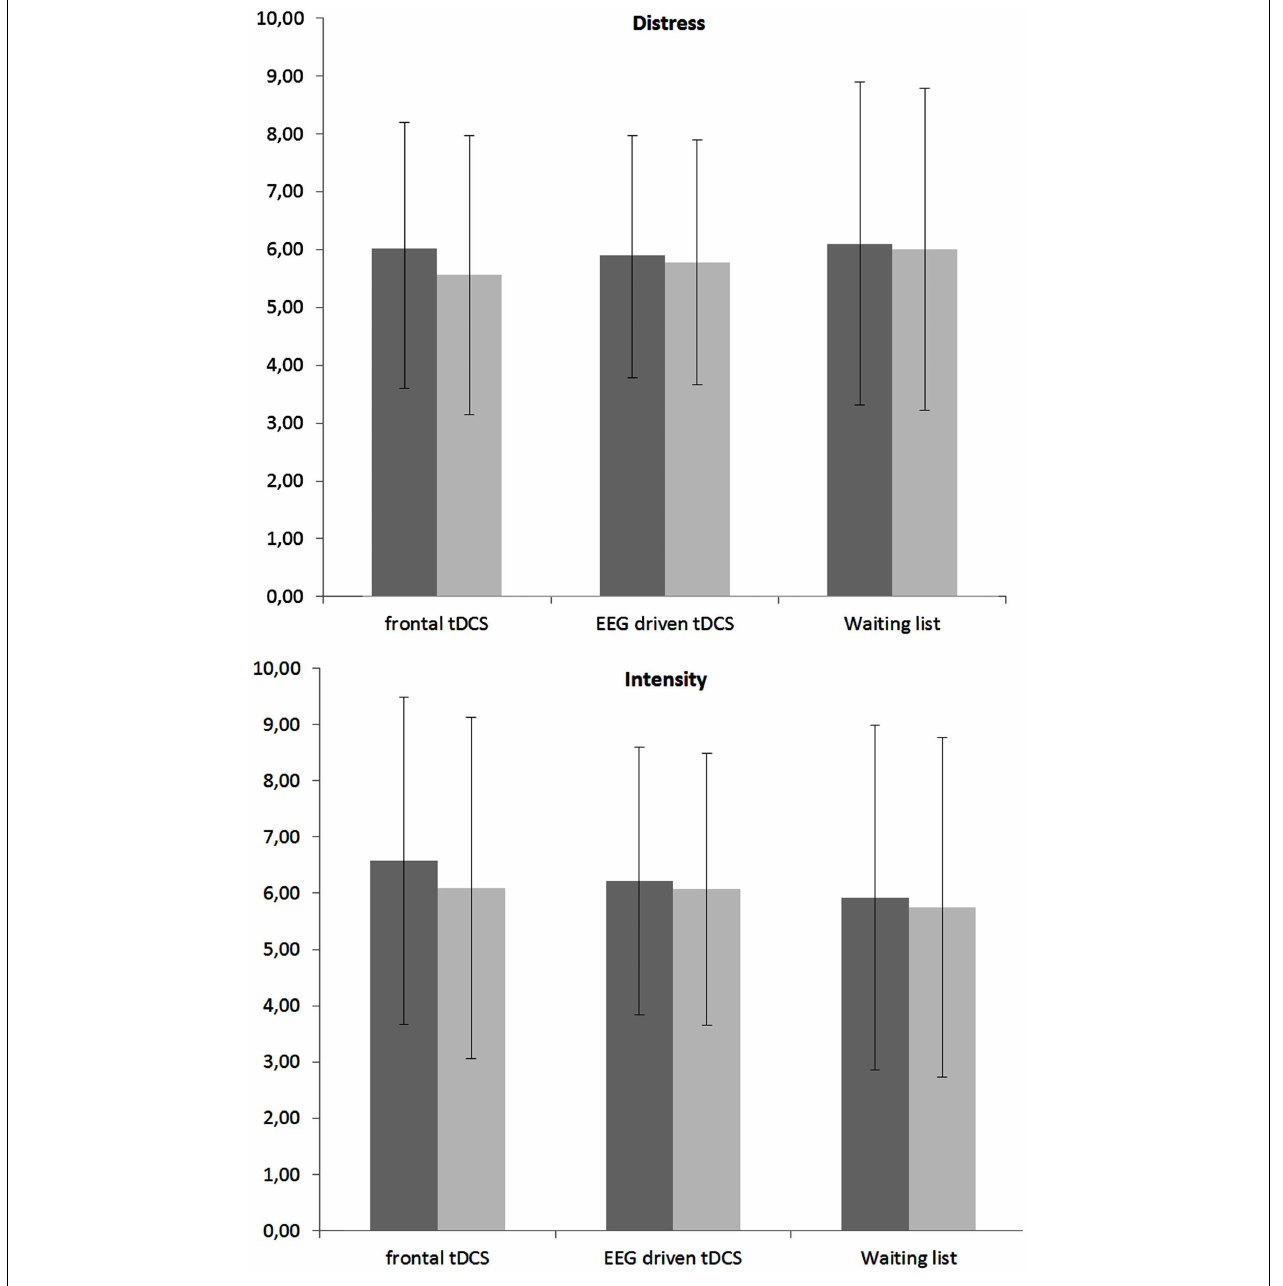
FIGURE 1 | MeanVAS score pre and post tDCS (within-subjects variable) for respectively frontal tDCS, EEG driven tDCS, and aWaiting list group (between-subjects variable) for both tinnitus distress and tinnitus